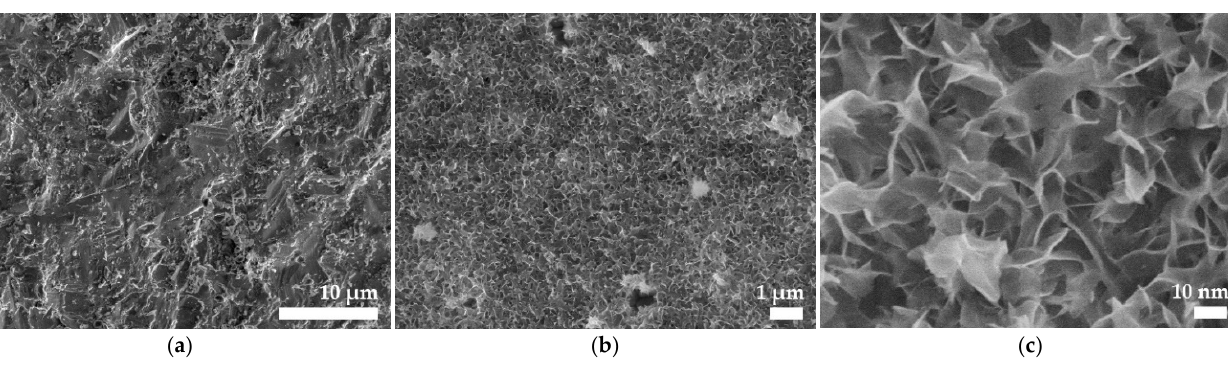
Figure 2. SEM micrograph showing a zirconia bonding surface that was followed by pretreatment: ( a ) APA resulting in surface flaws and sharp cuts (at magnification ×2500); ( b ) NAC application on the as-sintered zirconia surface (at magnification ×10,000); ( c ) NAC’s lamellar-like nanostructured topography (at magnification ×40,000).